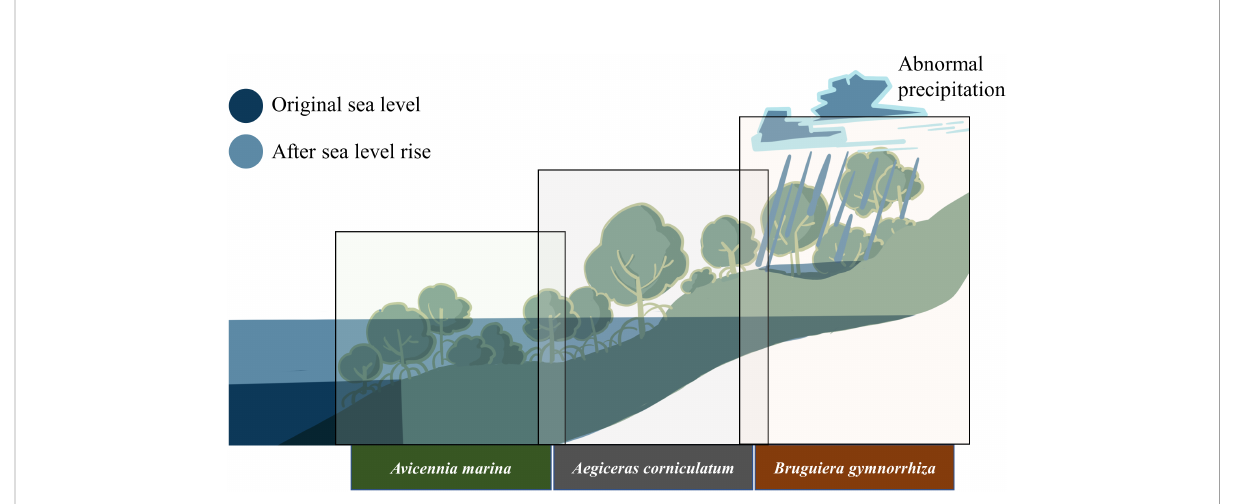
FIGURE 1 Diagram of the mangroves ’ intertidal distribution and climatic